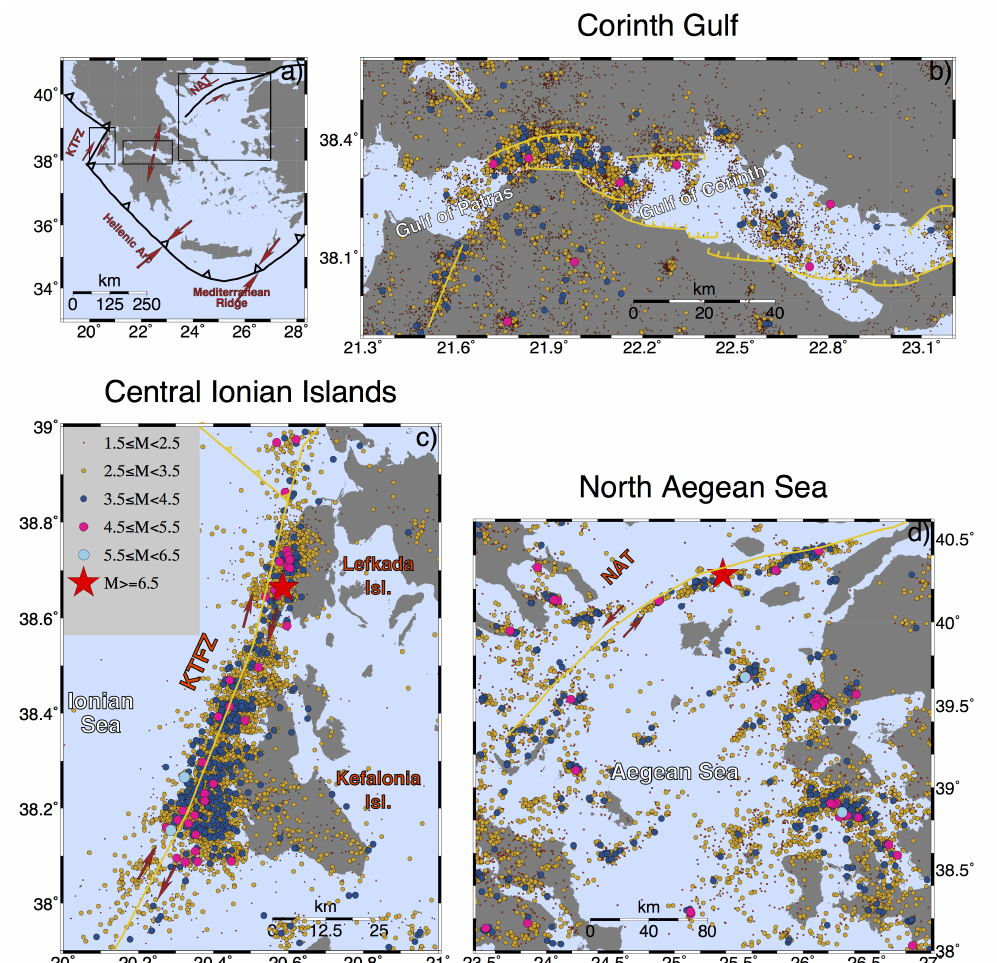
Figure 2. Maps of the study areas depicting seismicity along with major faults (yellow lines). ( a ) The main seismotectonic features of the area of Greece. The black lines illustrate the active boundaries and the arrows the relative plate motions. Rectangles enclose the three study areas. ( b ) The area of Corinth Gulf where the major faults are shown (yellow lines) along with seismicity during 2012–2019. ( c ) The area of Central Ionian Islands where the Kefalonia Transform Fault Zone and the collision front are shown (yellow lines) along with seismicity during 2012–2019. ( d ) The area of North Aegean Sea where the NAT is traced (yellow line) along with seismicity during 2012–2019. The legend is common for the three study